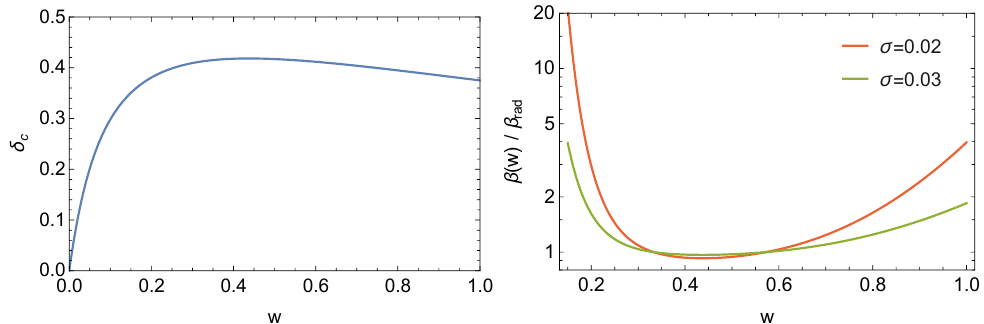
Figure 1. In the left panel the dependence of the threshold value (4) on the EOS, w , is plotted. In the right panel the increase of β , and consequently the PBH number density, with the hardening of the EOS is shown. The β ( w ) value has been normalized by the β ( w = 1/3 ) ≡ β rad value. The effect becomes stronger for smaller σ